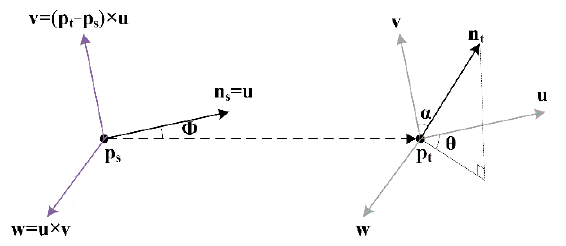
Figure 5. Local coordinate system.